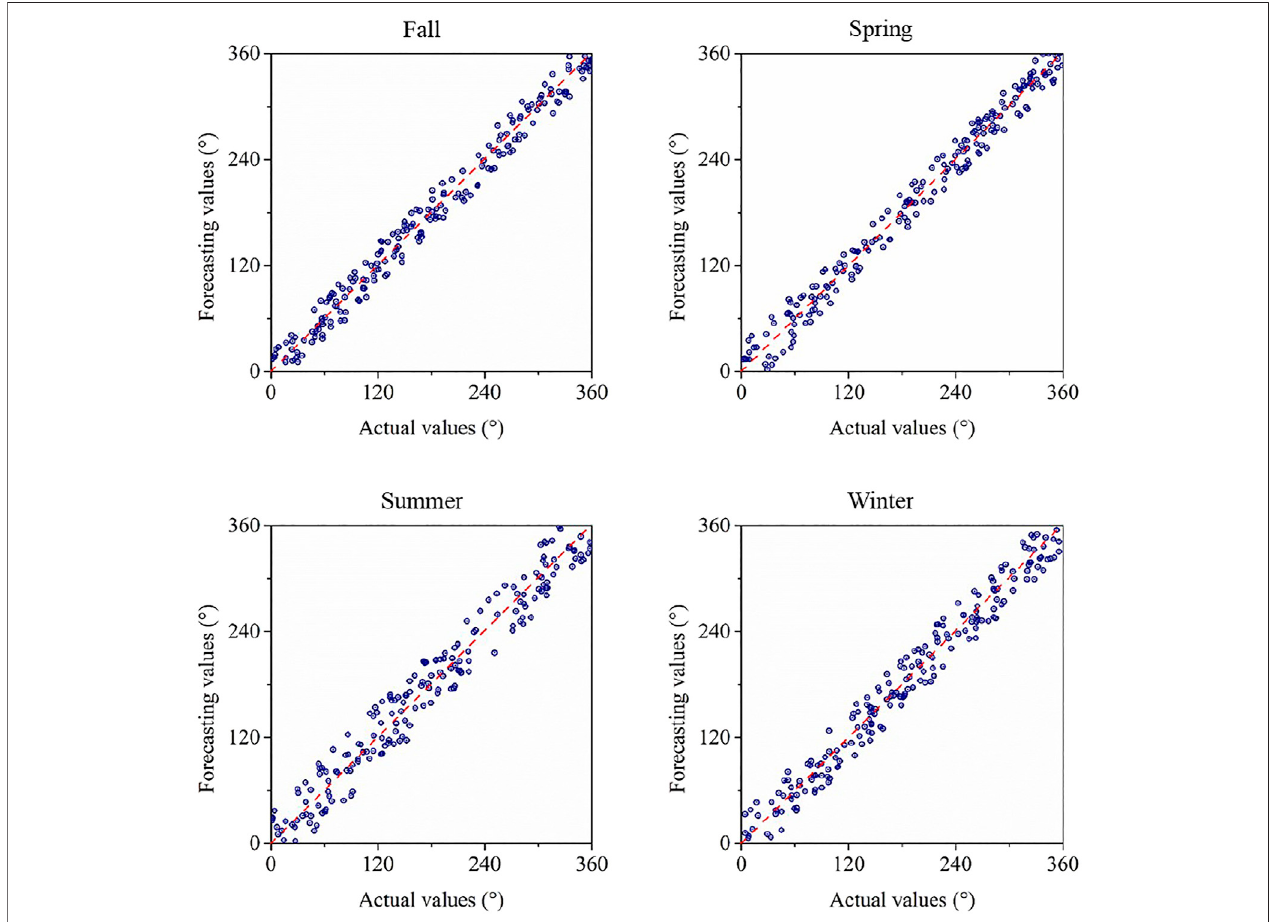
FIGURE 8 | Actual angular values versus forecasting angular values.